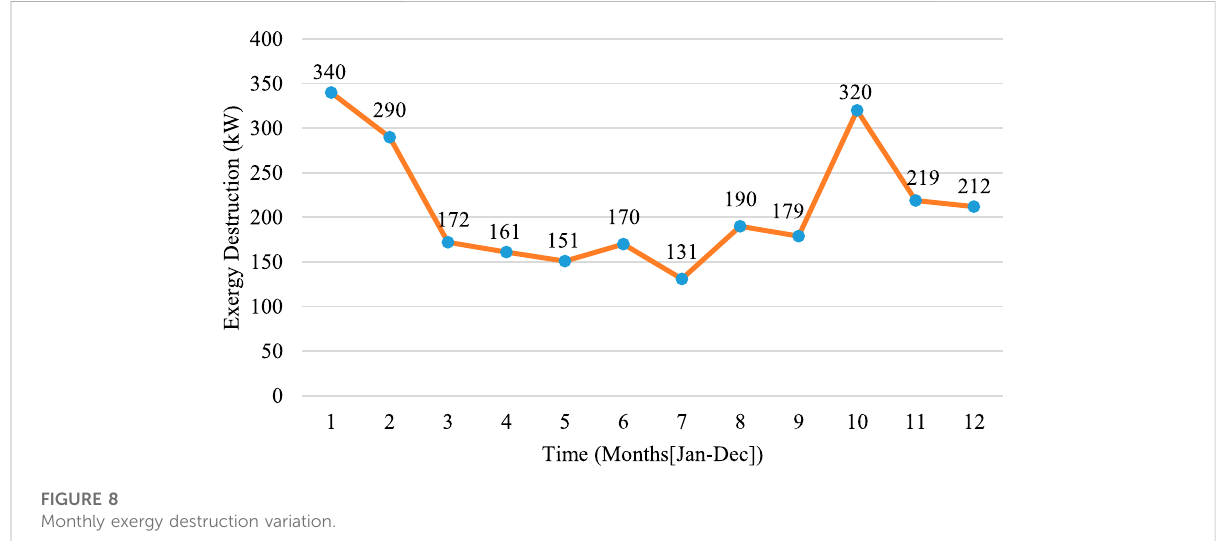
FIGURE 8 Monthly exergy destruction